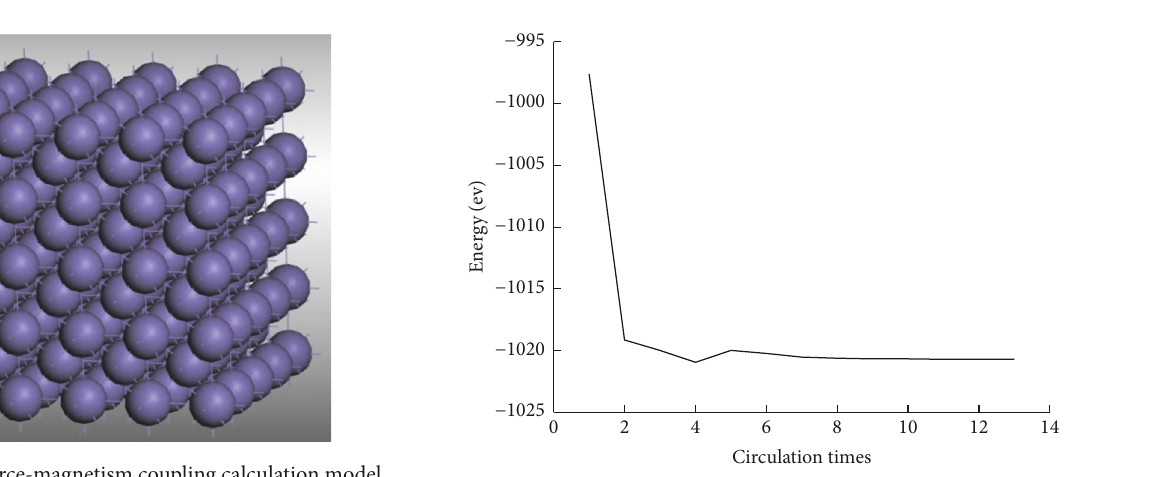
Figure 2: System